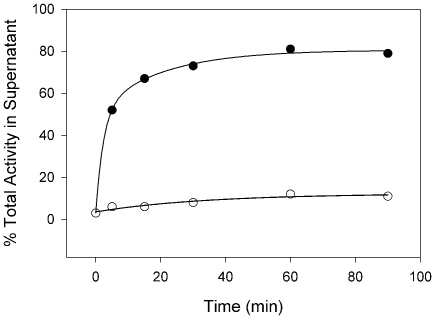
Release of BChE from transfected COS-7 cells by PIPLC.Equal aliquots of transfected cells were harvested intact and incubated at 37°C in PBS in the presence (•) or absence (○) of 4 units/ml of PIPLC, and cells and supernatants were assayed for BChE activity as described in Materials and Methods. Percent of the total activity recovered that is present in the supernatant is indicated.